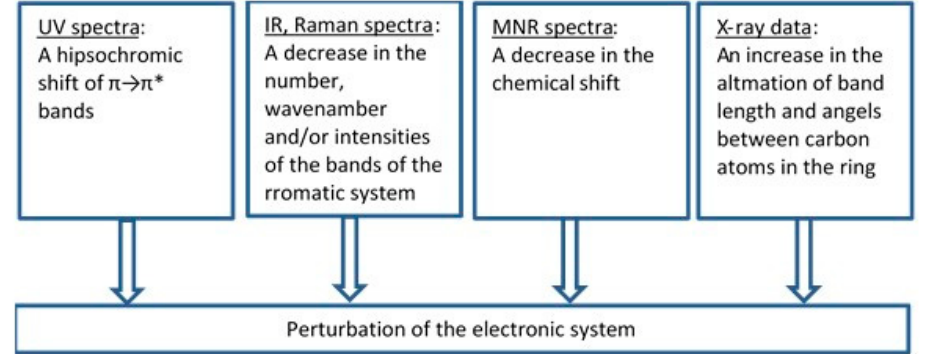
Figure 8. The criteria that were applied to estimate the degree of the electronic charge perturbation of molecule.